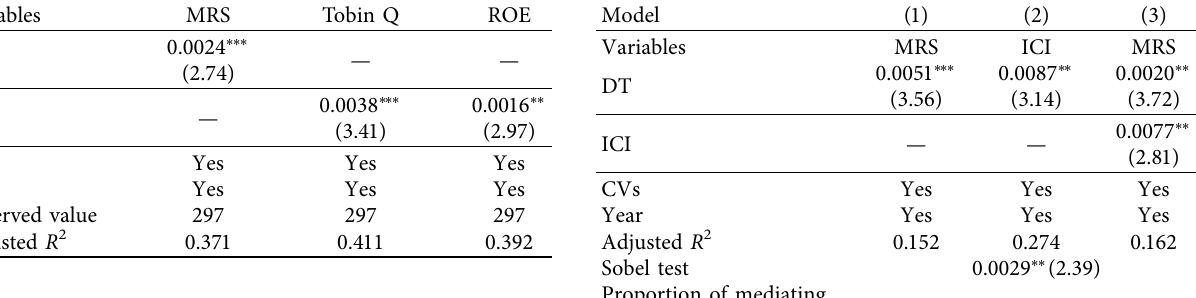
Table 6: Robustness test: variable substitution. Variables